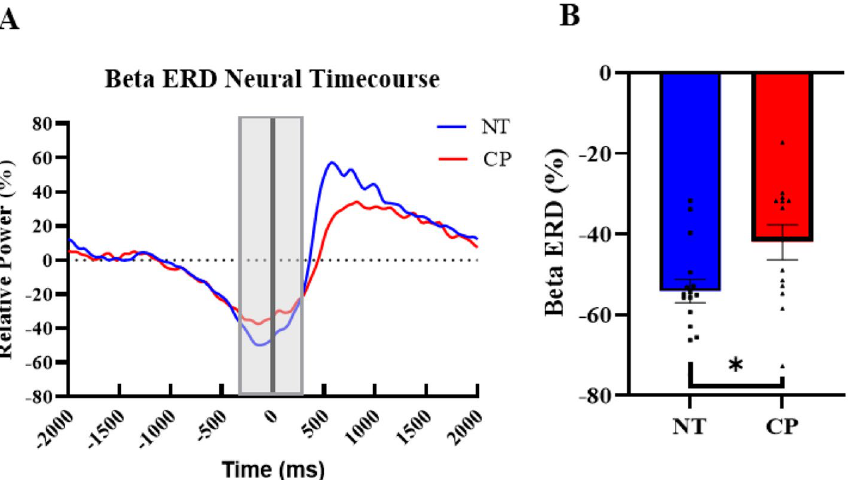
Figure 4. Beta ERD neural timecourse. ( A ) Neural timecourses of the beta ERD response in individuals with CP (red) and the NT group (blue) extracted from the peak voxel of the beta ERD response. The black line at 0.0 ms denotes movement onset, and the gray box is the window of interest (− 300 to 300 ms). ( B ) Bar graph depicting the difference in beta ERD strength between the NT and CP groups. As depicted, the beta ERD response was stronger in the NT group relative to those with CP. *P < 0.05.